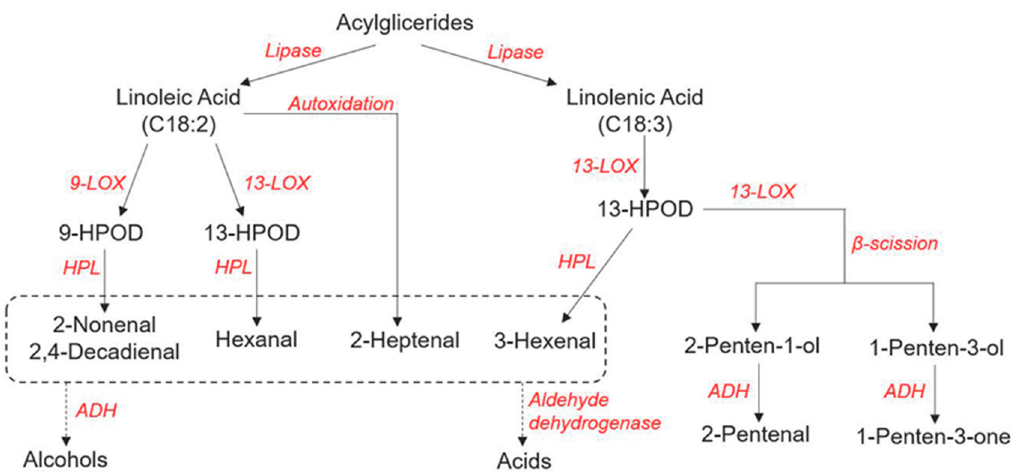
Figure 2. Overview of the lipid VOCs pathway, adapted from [118–120].